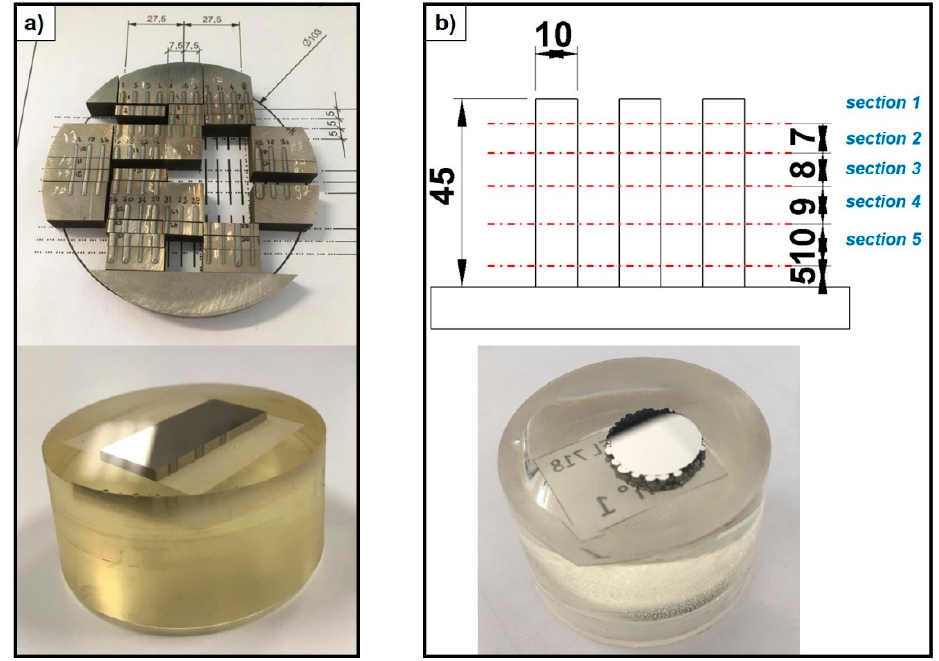
Figure 7. ( a ) ST cuts and cross-sections (mm); ( b ) cut positions for the structural analysis of as-built Inconel 718 cylinders and as-built cylinder cross-section (mm).